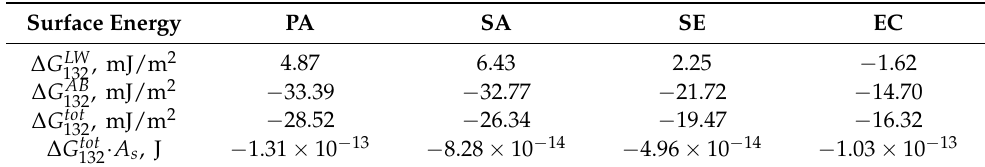
Table 1. Numerical experimental surface energy results for bacteria (PA, SA, SE, and EC) with super- hydrophobic substrates where the subscripted 132 indicates bacteria dispersed in water interacting with a superhydrophobic